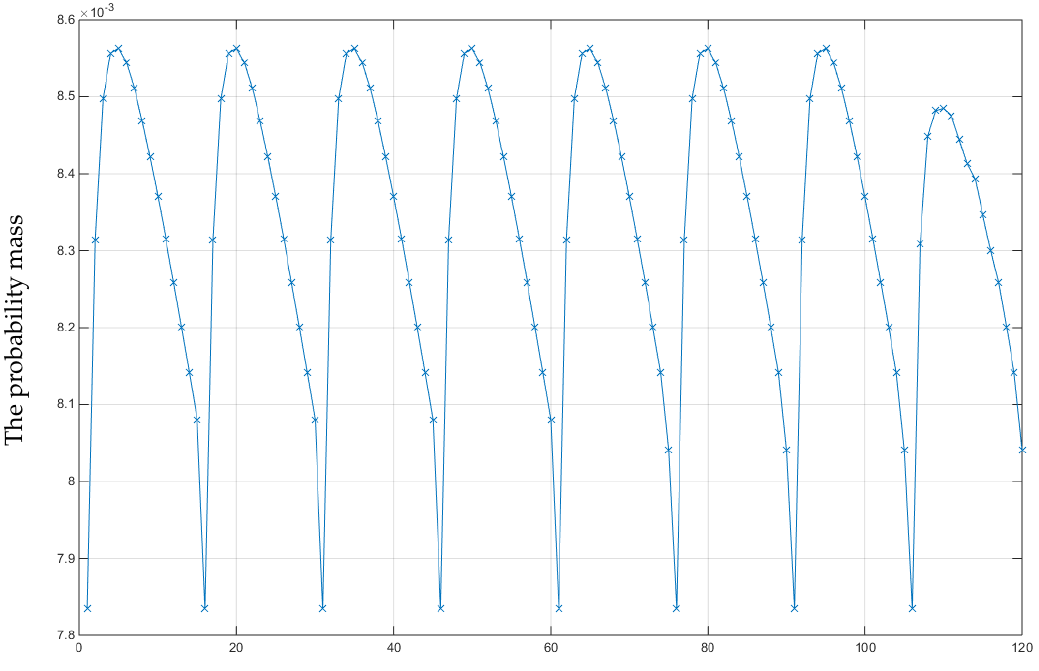
Figure 4. The probability mass of all the hyper-parameter configurations after 25 iterations of the proposed Hedge-based algorithm ( T = 25–50).